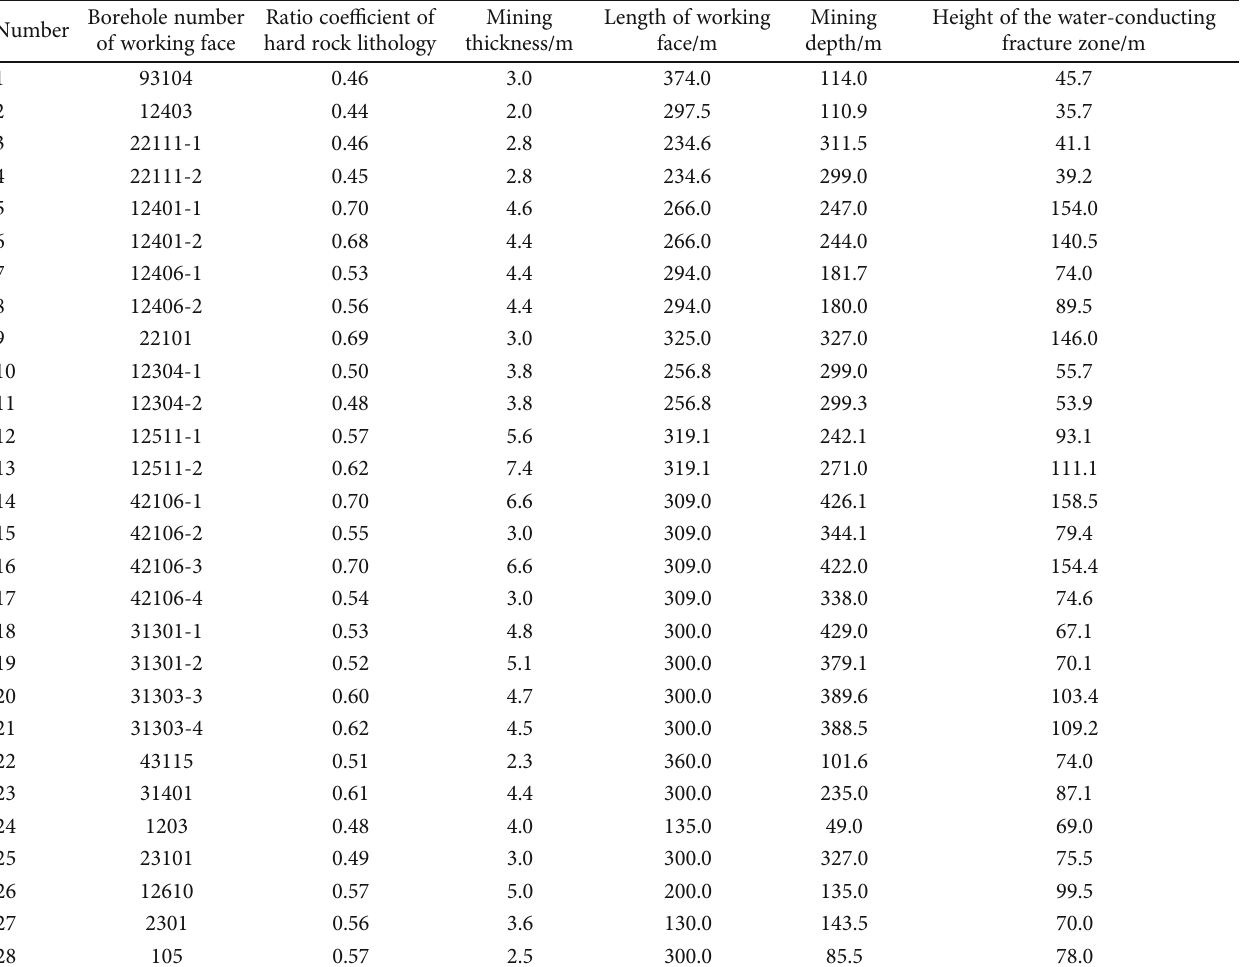
Table 1: Data of the height of the water-conducting fracture zone and in fl uence factors. Borehole number Number of working